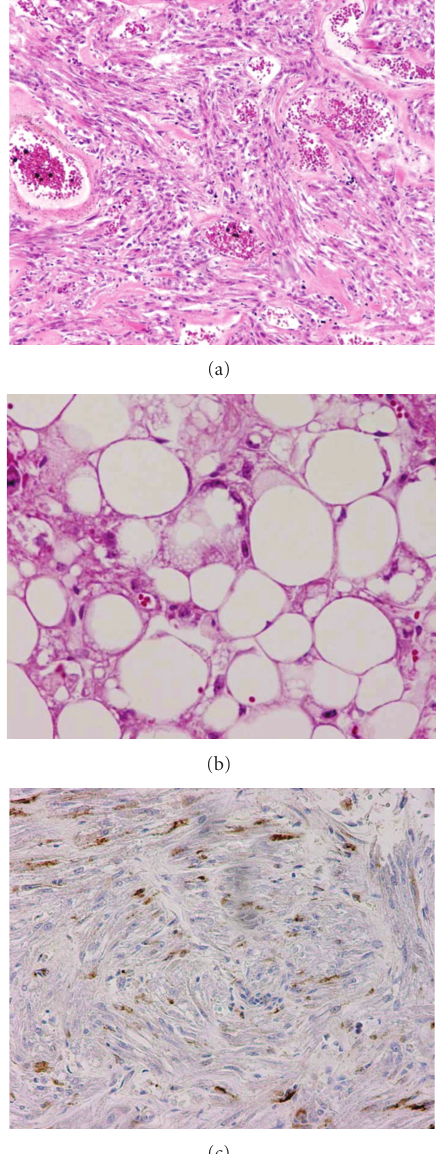
Figure 3: Angiomyolipoma (AML). The proliferation and infiltra- tion of AML cells, including spindle-shaped and epithelioid cells, malformed vessels (a), and fat (b) are demonstrated. HMB-45 is positive (c).